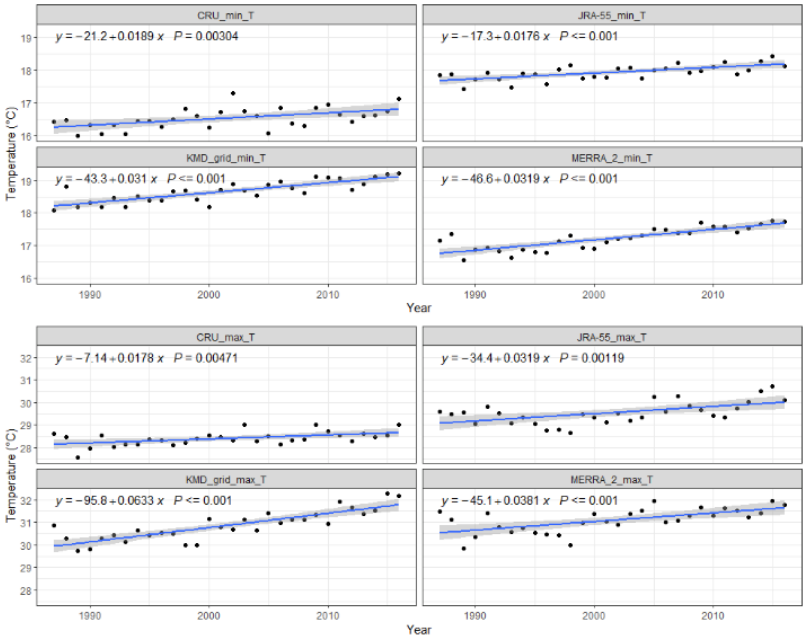
Figure 4. Significant annual maximum (Tmax) and minimum (Tmin) temperature trends in the MERRA-2, KMD_grid, CRU, and JRA-55 gridded products. The black dots represent annual precipi- tation values with the blue line indicating the linear regression.